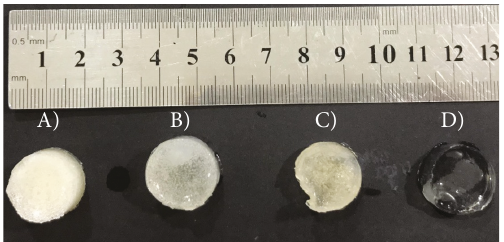
Figure 4: Hydrogels of gelatin and pectin, with di ff erent oxidation levels, after 72 h of swelling in a SBF at 32 ° C. From left to right, the four samples are H.6.20 (6% HOP and 20% of gelatin), L.6.20 (6% LOP and 20% of gelatin), N.6.20 (6% NOP and 20% of gelatin), and 0.20 solely gelatin (20% gelatin).